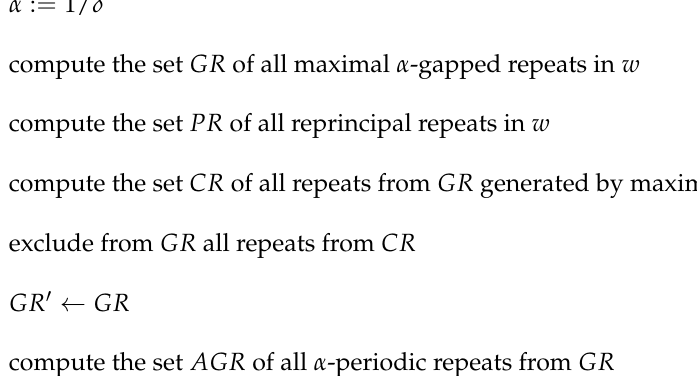
Algorithm 1 Algorithm for solving Problem